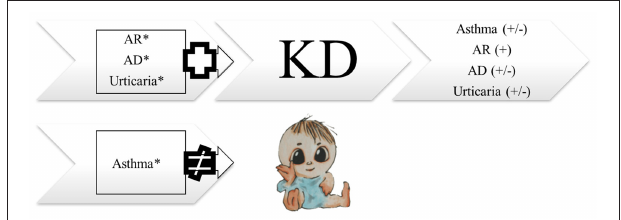
FIGURE 1 | The association between Kawasaki disease and allergic diseases. AD, atopic dermatitis; AR, allergic rhinitis; KD, Kawasaki disease. *derived from Wei et al. (28).